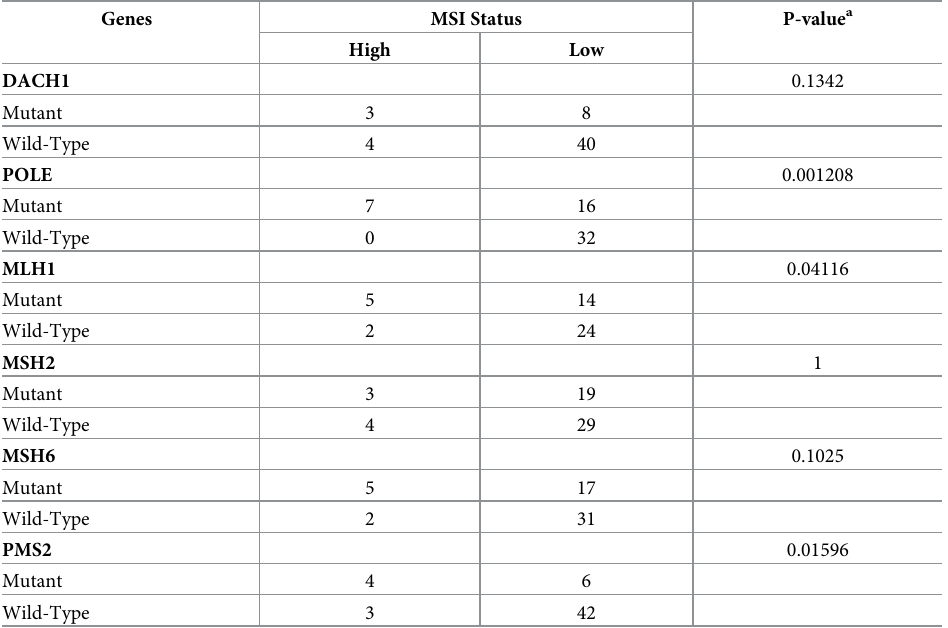
Table 8. Relationship of gene mutations with microsatellite instability at MCC. Genes MSI Status P-value a High Low DACH1 0.1342 Mutant 3 8 Wild-Type 4 40 POLE 0.001208 Mutant 7 16 Wild-Type 0 32 MLH1 0.04116 Mutant 5 14 Wild-Type 2 24 MSH2 1 Mutant 3 19 Wild-Type 4 29 MSH6 0.1025 Mutant 5 17 Wild-Type 2 31 PMS2 0.01596 Mutant 4 6 Wild-Type 3 42 Microsatellite instability in DACH1 mutated patients compared to wild-type. MSI was calculated by MSISensor2, which assumes MSI-H � 20%. Correlation of DACH1 mutations with microsatellite instability status was not significant (p-value = 0.1342). a P-values calculated using the Fisher’s exact